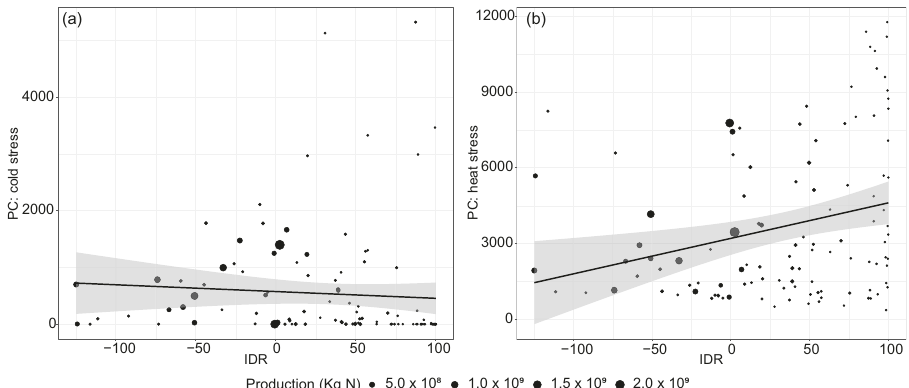
Fig. 1 Relationship between import dependency ratio and weather stress. Relationships between the 2005 – 2014 import dependency ratio (IDR; Eq. 1) and derived principal components (PCs) representing the weather stress: ( a ) cold stress, ( b ) heat stress. Positive IDR means higher import dependency, while a negative IDR means that a country is a net exporter. Each black point represents a country, the size of the point corresponds to the average wheat production during 2005 – 2014. The black lines represent the estimated linear relationships between weather stress and IDR ( p -value = 0.460 for cold stress and 0.005 for heat stress), gray shaded areas correspond to 95% con fi